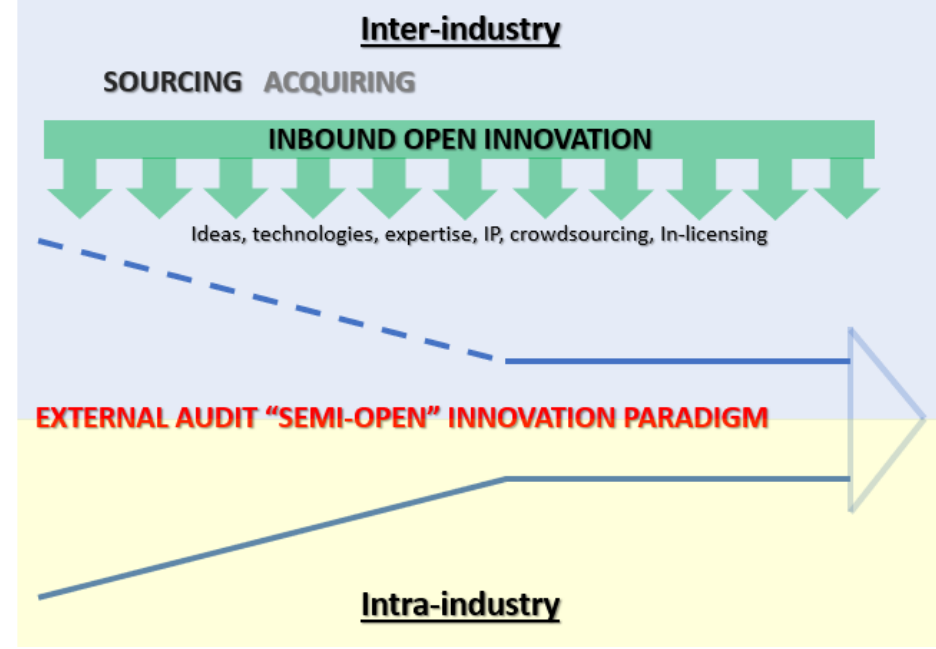
Figure 1. External Audit “Semi ‐ Open” innovation paradigm.